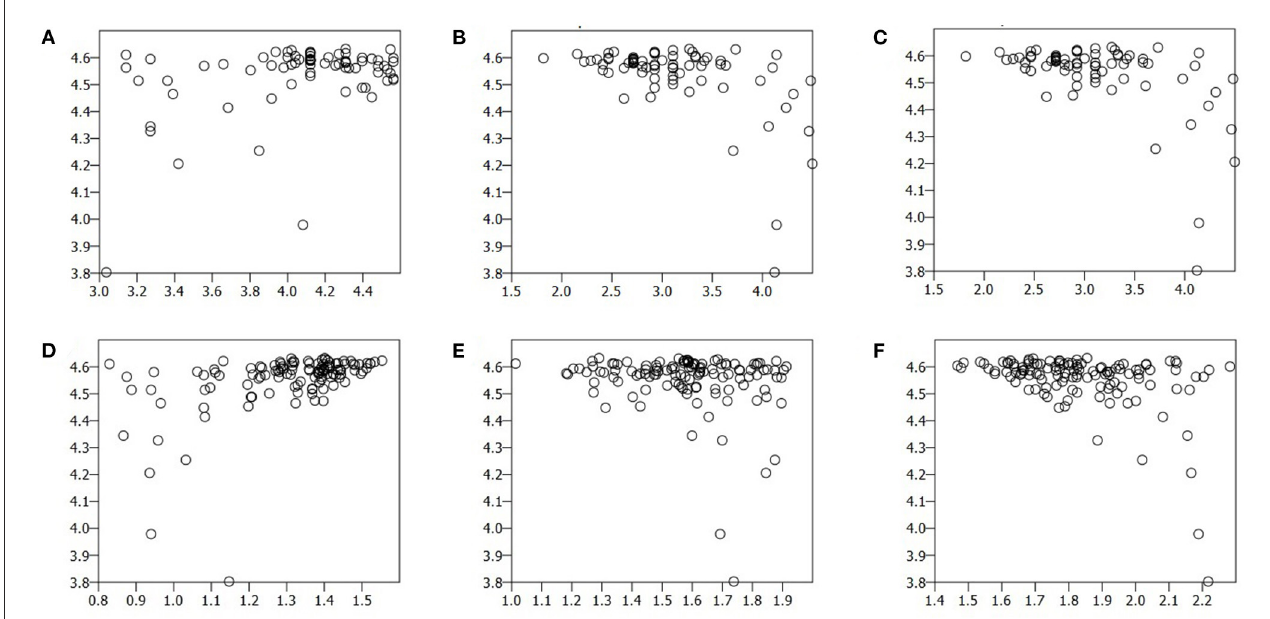
FIGURE1 Scatterplots of lifetime national breastfeeding rates (Y-axis) plotted against (A) Hofstede’s power distance index, (B) Hofstede’s individualism-collectivism index, (C) Hofstede’s masculinity-femininity index, (D) Global collectivism index, (E) prevalence of depression in women aged 15–49, and (F) prevalence of anxiety disorders in women aged 15–49 (X-axis). See the text for details of variable transformation prior to